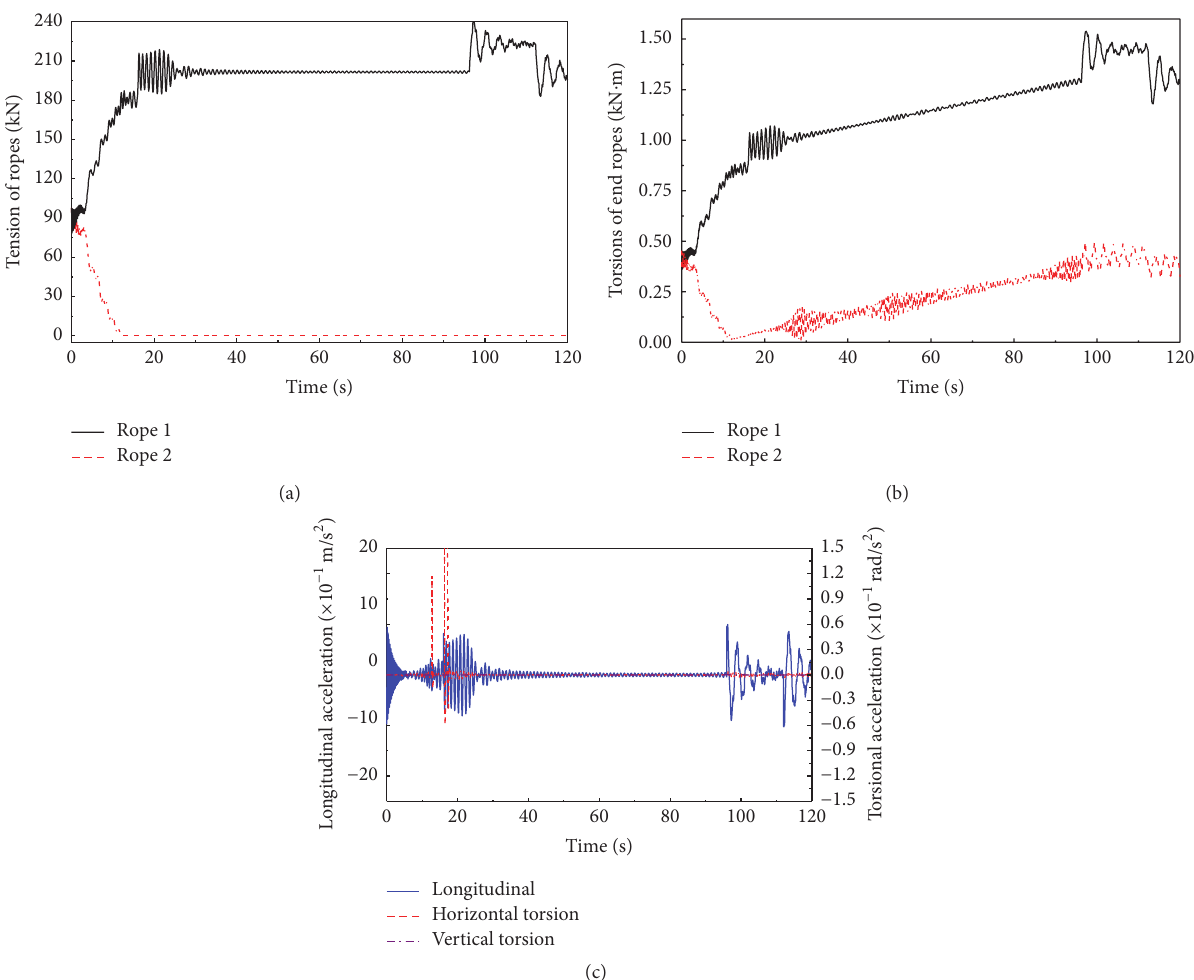
Figure 7: (a) Tensions, (b) torsions of the end ropes, and (c) accelerations of conveyance, calculated using 𝜉 = 0.0015 .